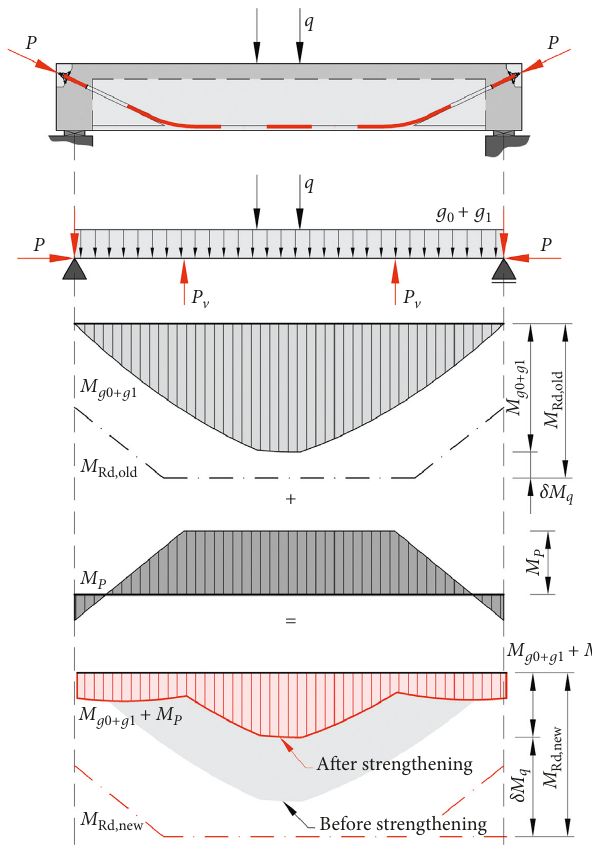
Figure 11: The basic scheme of prestressing static effect on the simple span bridge (reduction of dead load bending moments—application of LBM). Prestressing creates a much bigger reserve of bearing capacity which can be used for traffic load, and therefore, the load-bearing capacity is increased. The efficiency of this method is up to